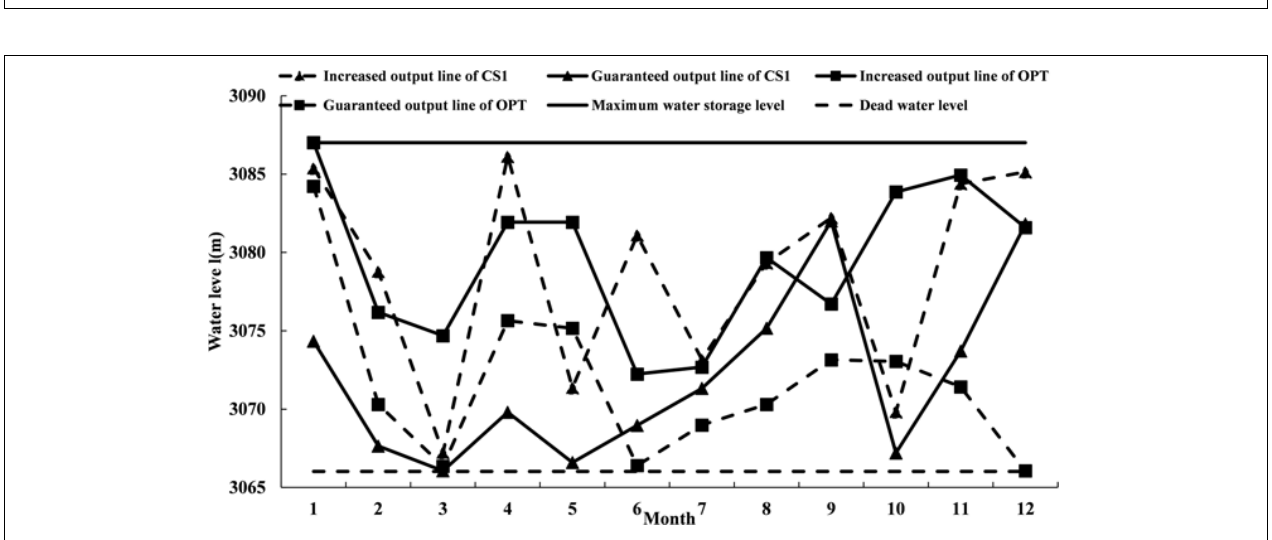
FIGURE 7 | Location of the optimal schemes in the Pareto scheme set. Triangle represents the comparison schemes (CS1 and CS2) and square represents the optimal scheme (OPT). (A) Pareto frontier projection of power generation target and water supply target. (B) Pareto frontier projection of power generation target and water diversion target.